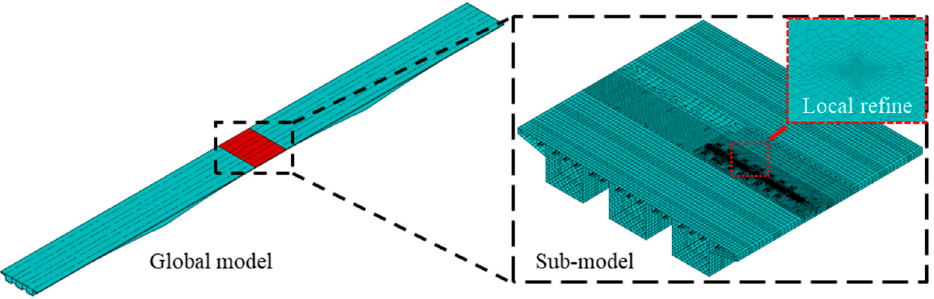
Figure 12. Multi-scale finite element model of the prototype bridge.